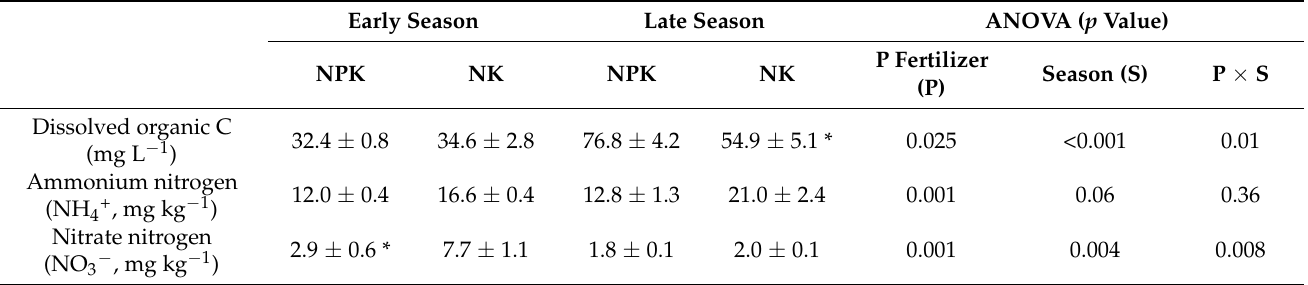
Table 2. The effect of long-term P addition on soil DOC, NH 4+ , and NO 3 − concentrations during early and late rice seasons.